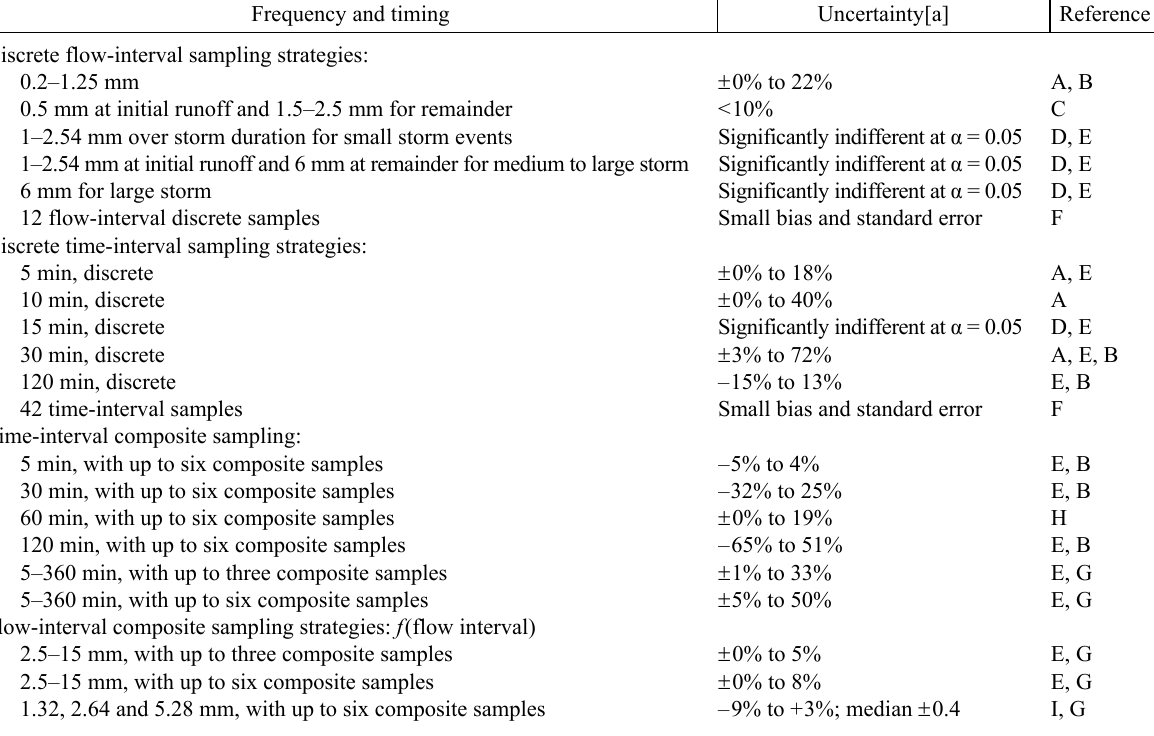
Table 3. Discrete and composite sample collection frequency and timing with relative uncertainty [20,21,74,84,92] Frequency and